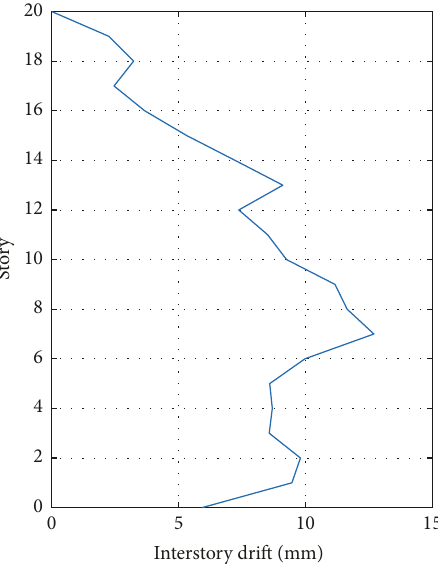
Figure 15: Peak interstory drifts.